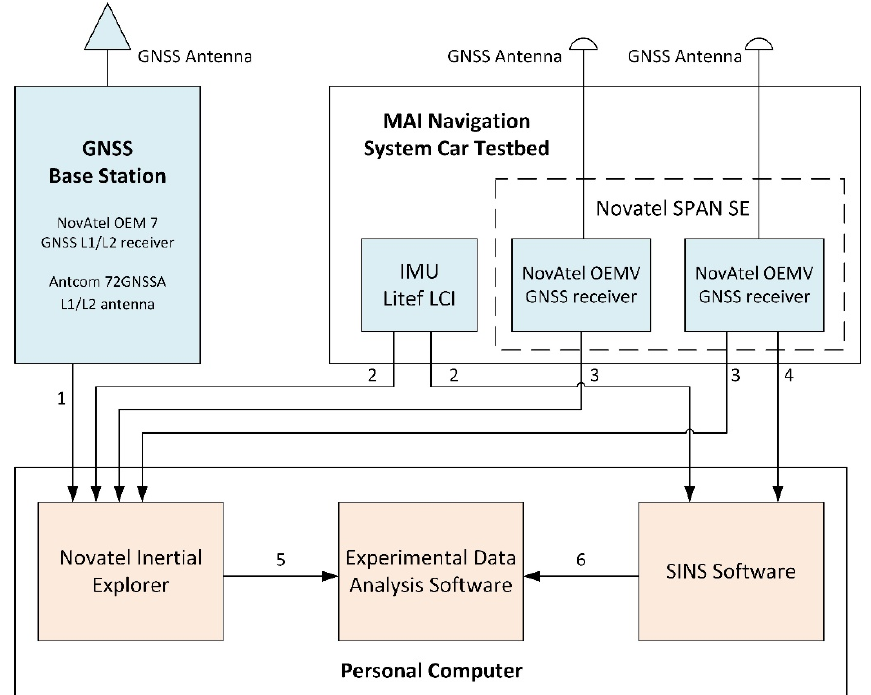
Figure 3. Car test experimental setup (1—GNSS Base Station Raw Measurements, 2—IMU measurements, 3—GNSS Rover Receivers Raw Measurements, 4—GNSS Navigation Data, 5—